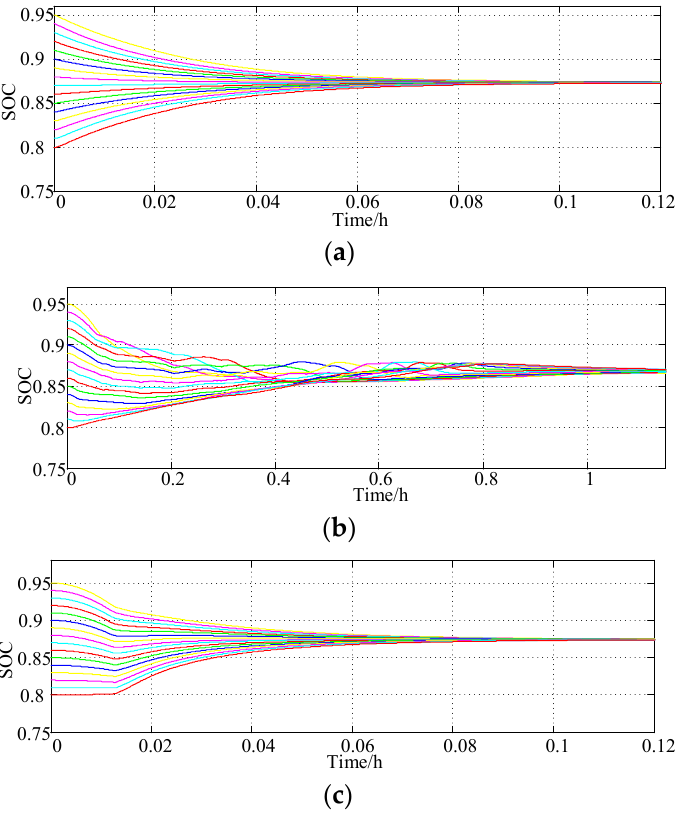
scheme; and ( c ) the layer-based equalisation scheme.